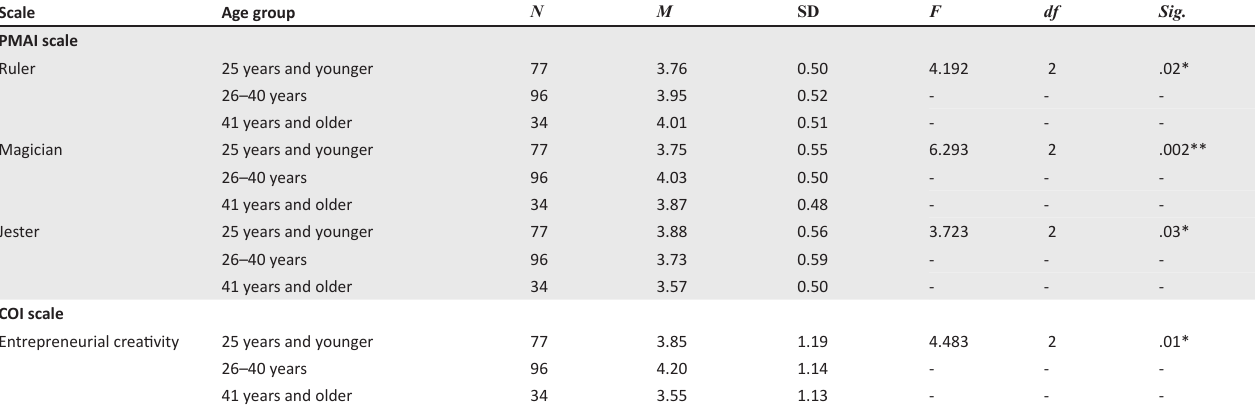
TABLE 6 : Significant differences between age groups: ANOVA. Scale